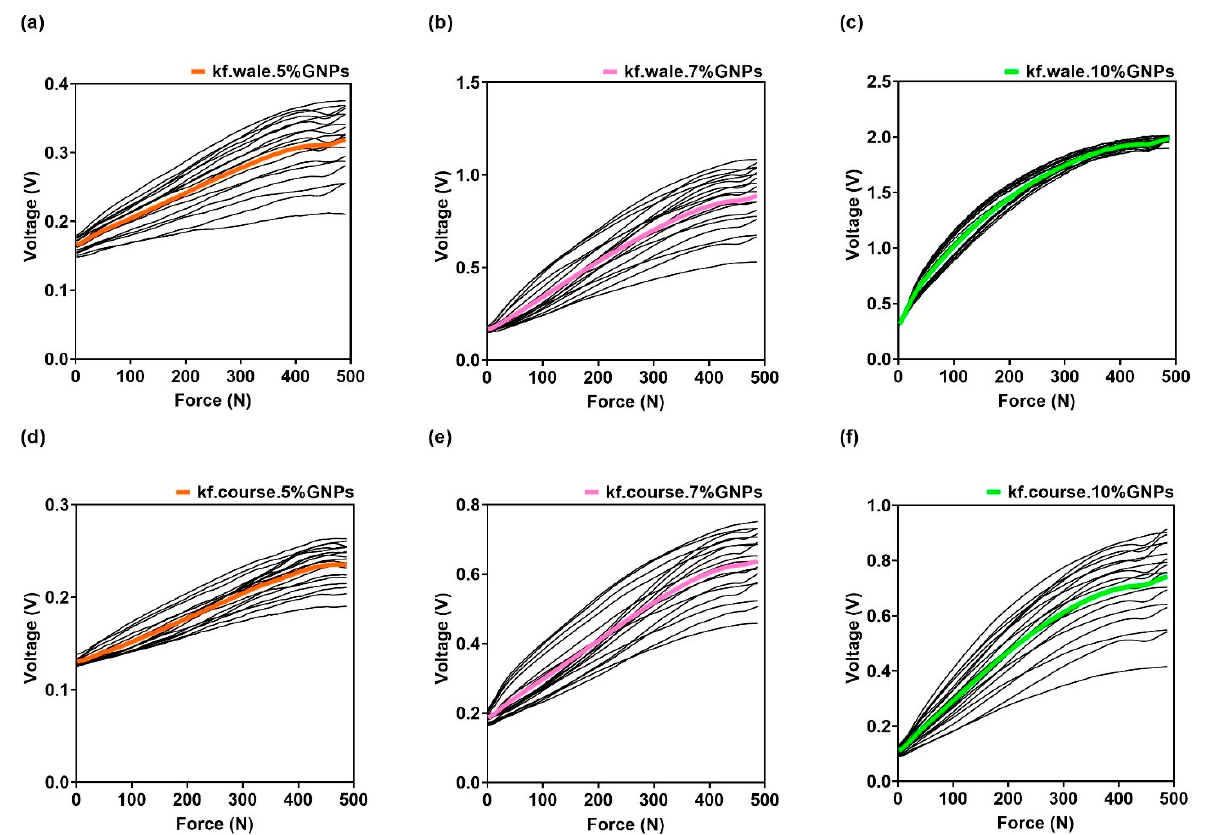
Figure 12. In black, Voltage signals acquired according to the sensor’s resistance, under 10 mechanical compression cycles for ( a ) knitted fabric sensor doped with 5% GNPs and assembled in the walewise direction; ( b ) knitted fabric sensor doped with 7% GNPs and assembled in the walewise direction; ( c ) knitted fabric sensor doped with 10% GNPs and assembled in the walewise direction; ( d ) knitted fabric sensor doped with 5% GNPs and assembled in the coursewise direction; ( e ) knitted fabric sensor doped with 7% GNPs and assembled in the coursewise direction; ( f ) knitted fabric sensor doped with 10% GNPs and assembled in the coursewise direction. The coloured curves represent the average values of voltage.